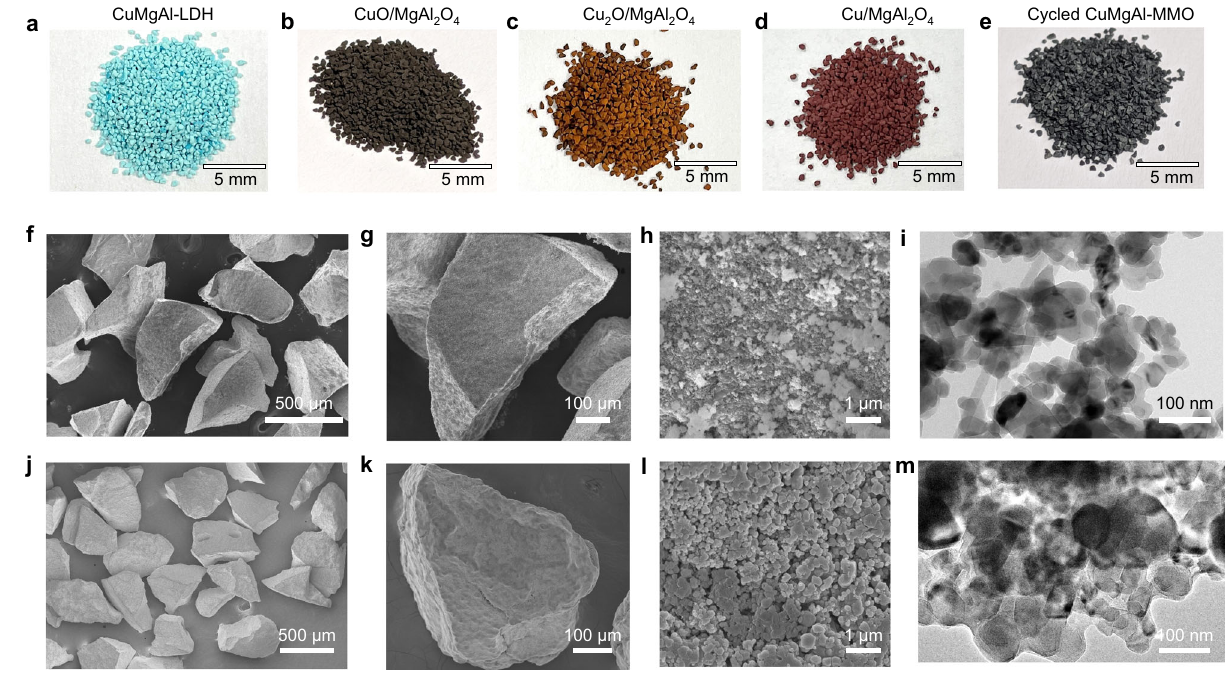
Fig. 4 | Shapeand morphologyevolutionofCuMgAl-MMO-HSparticles. Photos of CuMgAl-LDH precursors and derived MMOsin different states: a LDHprecursor powders, b freshlycalcinedparticles, c decomposedparticles(activephase:Cu 2 O), d reducedparticles(activephase:Cu)reductionunder2vol%CObalancedwithN 2 ,